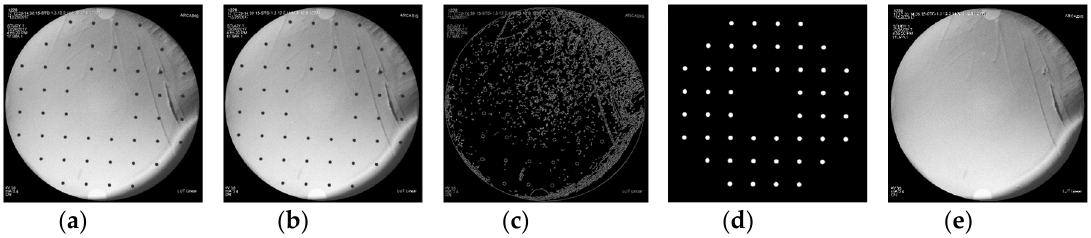
Figure 1. Rectification plate: ( a ) a rectification plate model; ( b ) Plate installment.